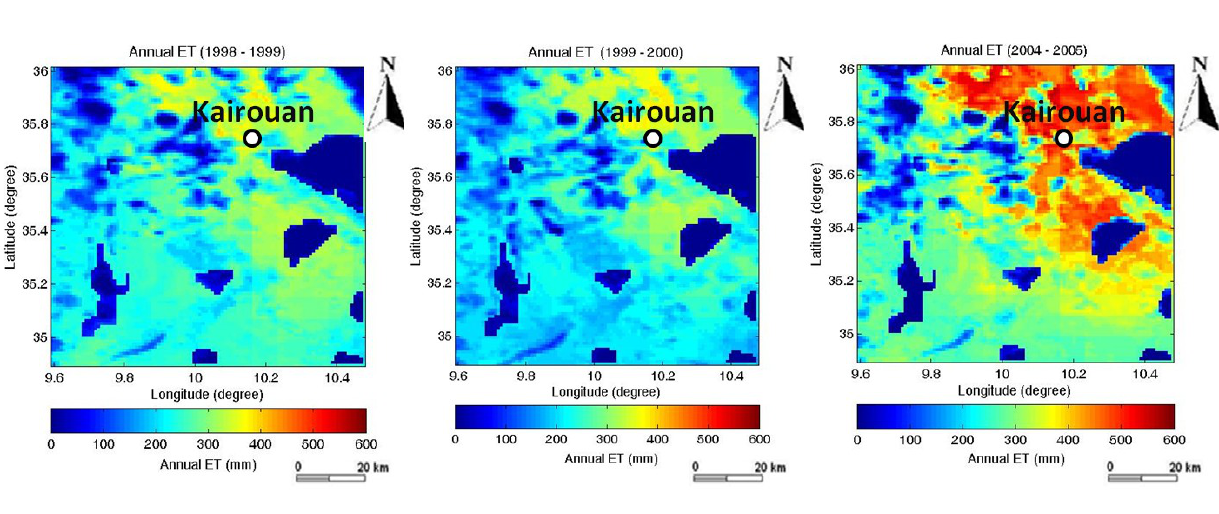
Figure 6. Total annual evapotranspiration maps: ( a ) 1998–1999 agricultural season; ( b ) 1999–2000 agricultural season; ( c ) 2004–2005 agricultural